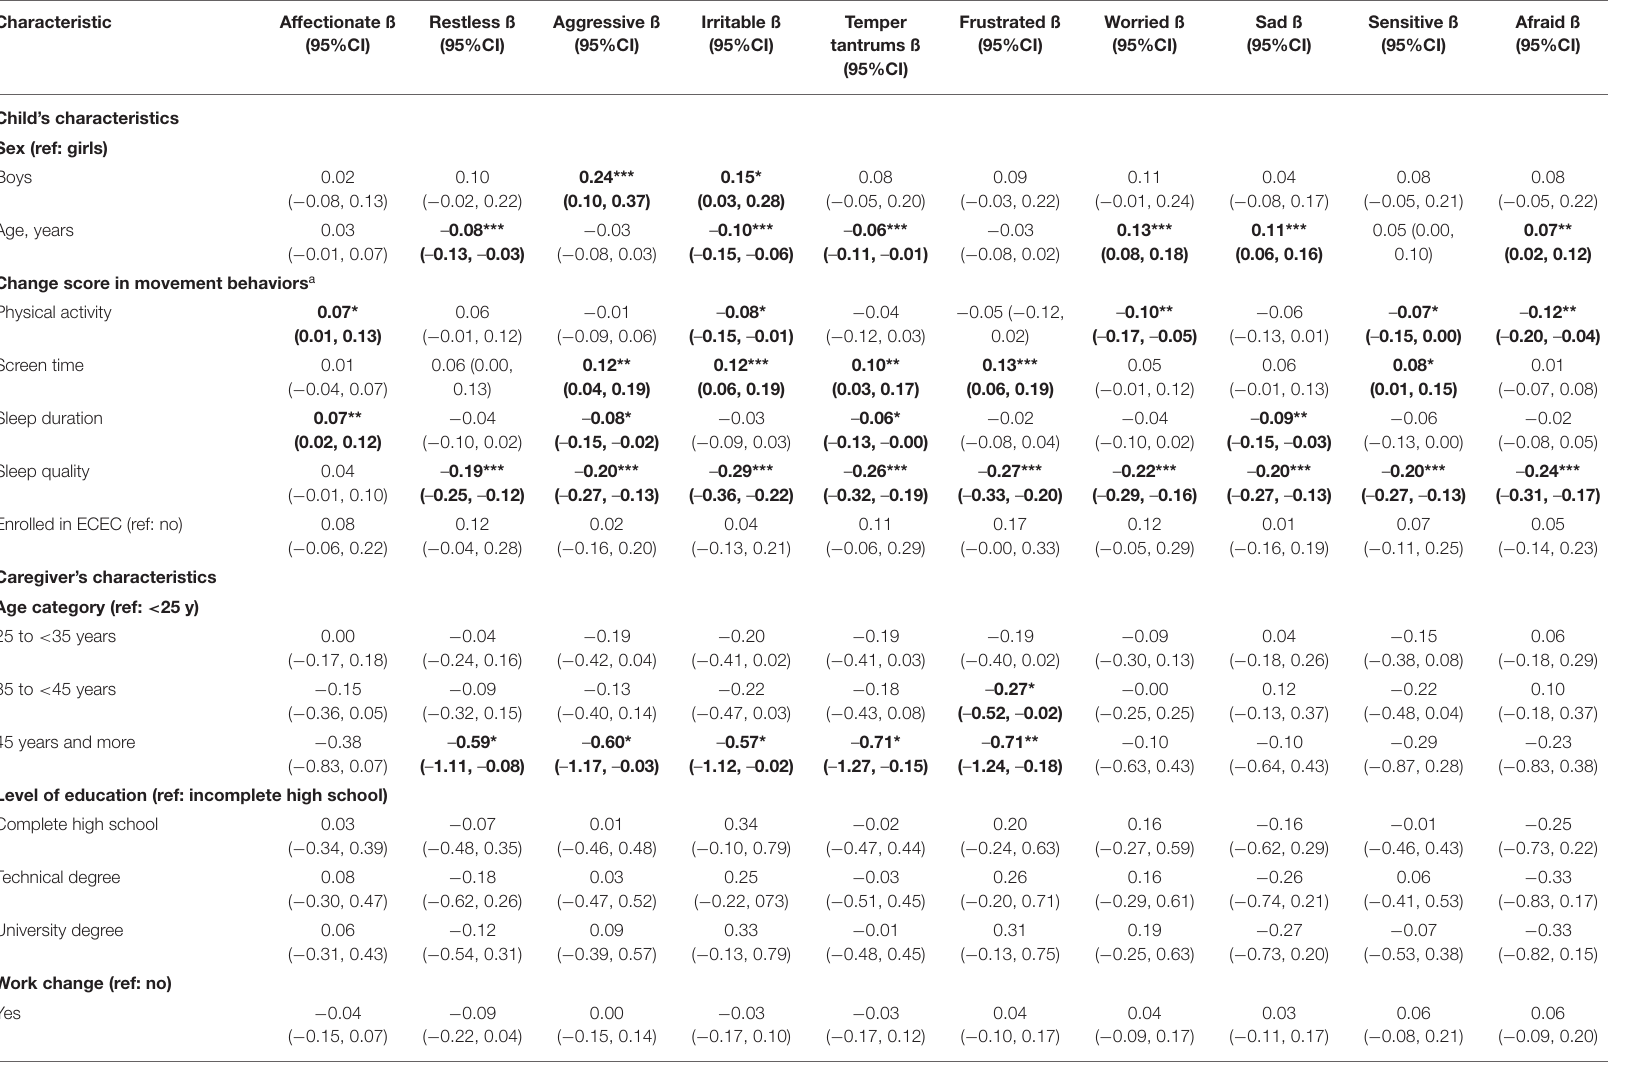
TABLE 2 | Child’s and caregivers’characteristics associated with emotional changes in toddlers and preschoolers during early stages of the COVID-19 pandemic ( n = 1,727).